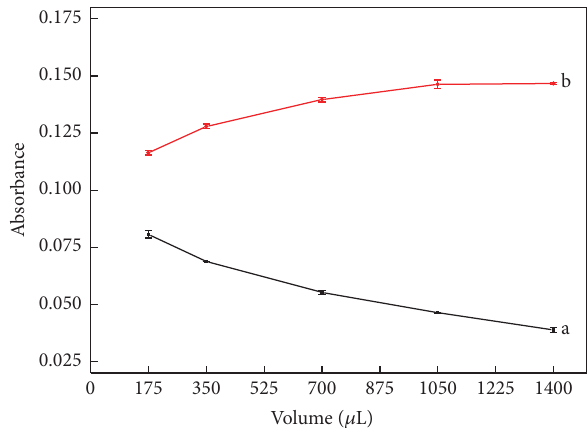
Figure 4: Effect of the iron (III) concentration on sensitivity. Curves a and b are related with blank and a 150 𝜇 gL −1 Mo(VI) standard solution, respectively. Experimental conditions: 0.44 molL −1 SnCl 2 ; blank and Mo (VI) standard solution in 1.5 molL −1 HC medium; 7 sampling cycles; sampling time intervals of 2.0 and 1.0 s for insertion sample and SCN − solution, respectively; pumping rate at 50 𝜇 Ls −1 .